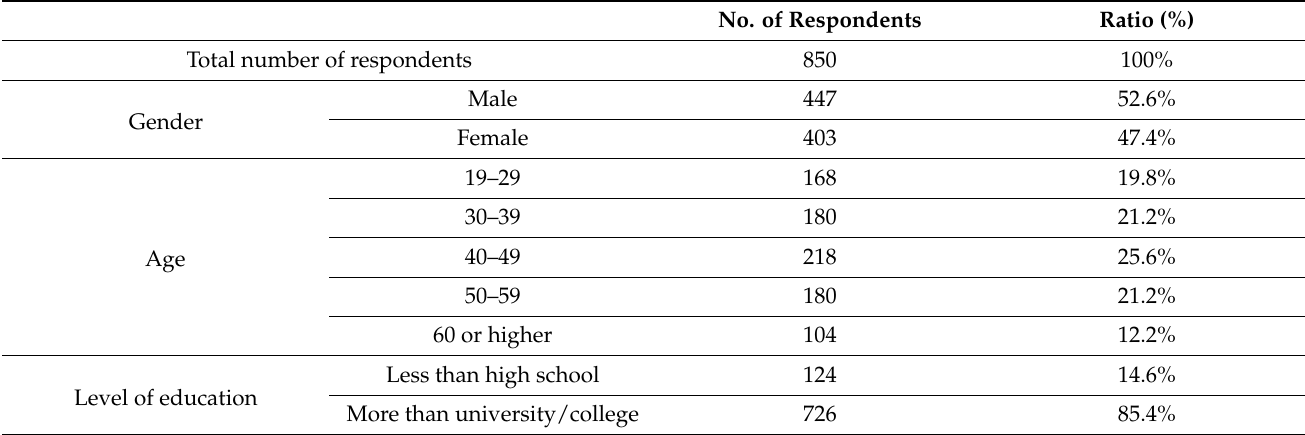
Table 1. Descriptive statistics of the